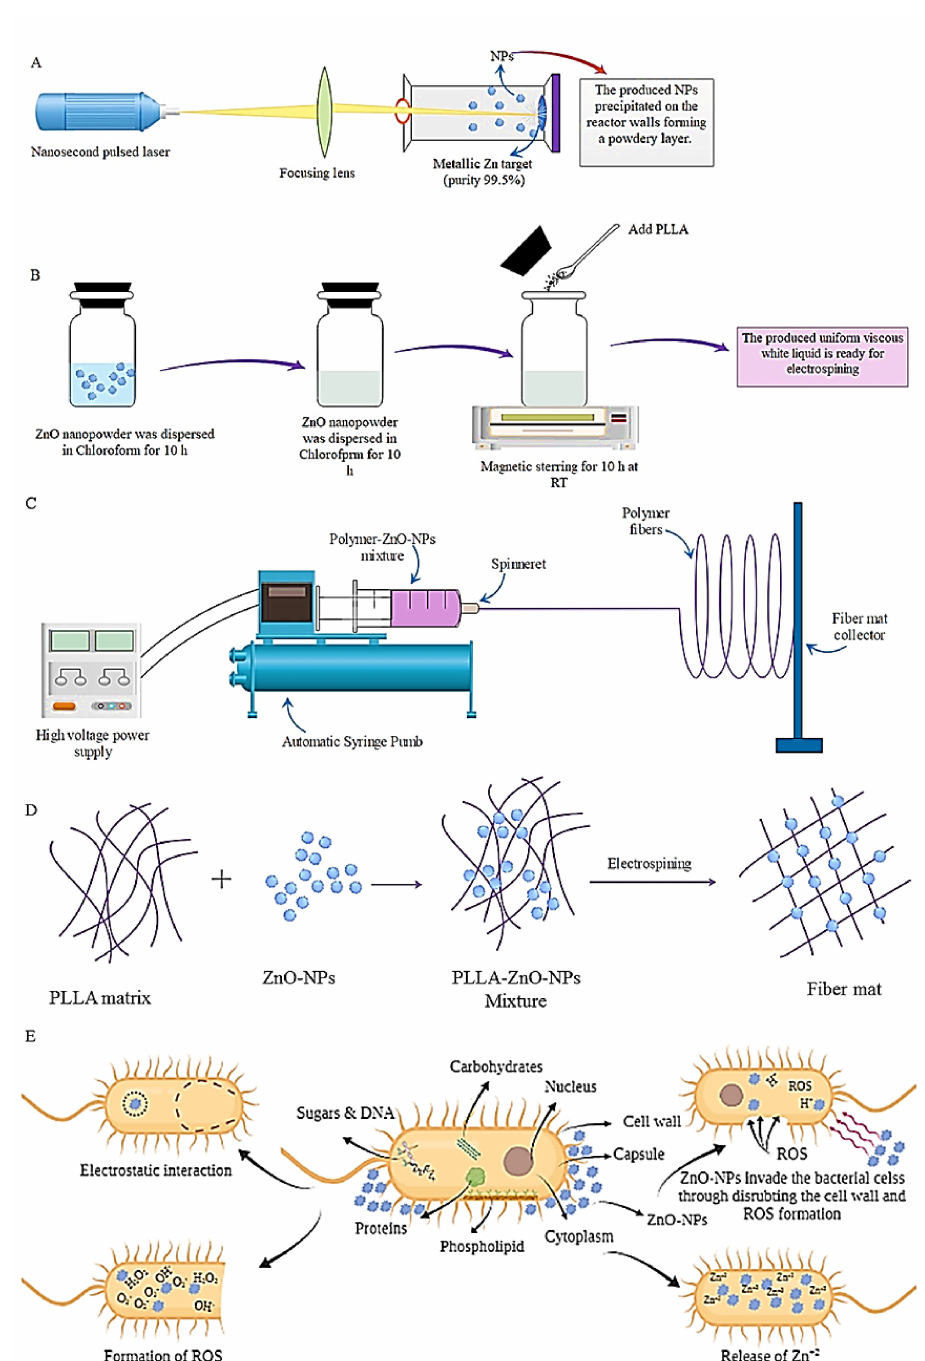
Figure 3. Schematic illustration for the preparation of ZnO-NPs via the pulsed laser ablation in air technique ( A ), fabrication of polymeric -NPs complex ( B ), formation of polymer loaded fibrous mat ( C ), schematic illustration of the ZnO-NPs distribution within fiber mat ( D ) and potential antibacterial mechanisms of ZnO-NPs ( E